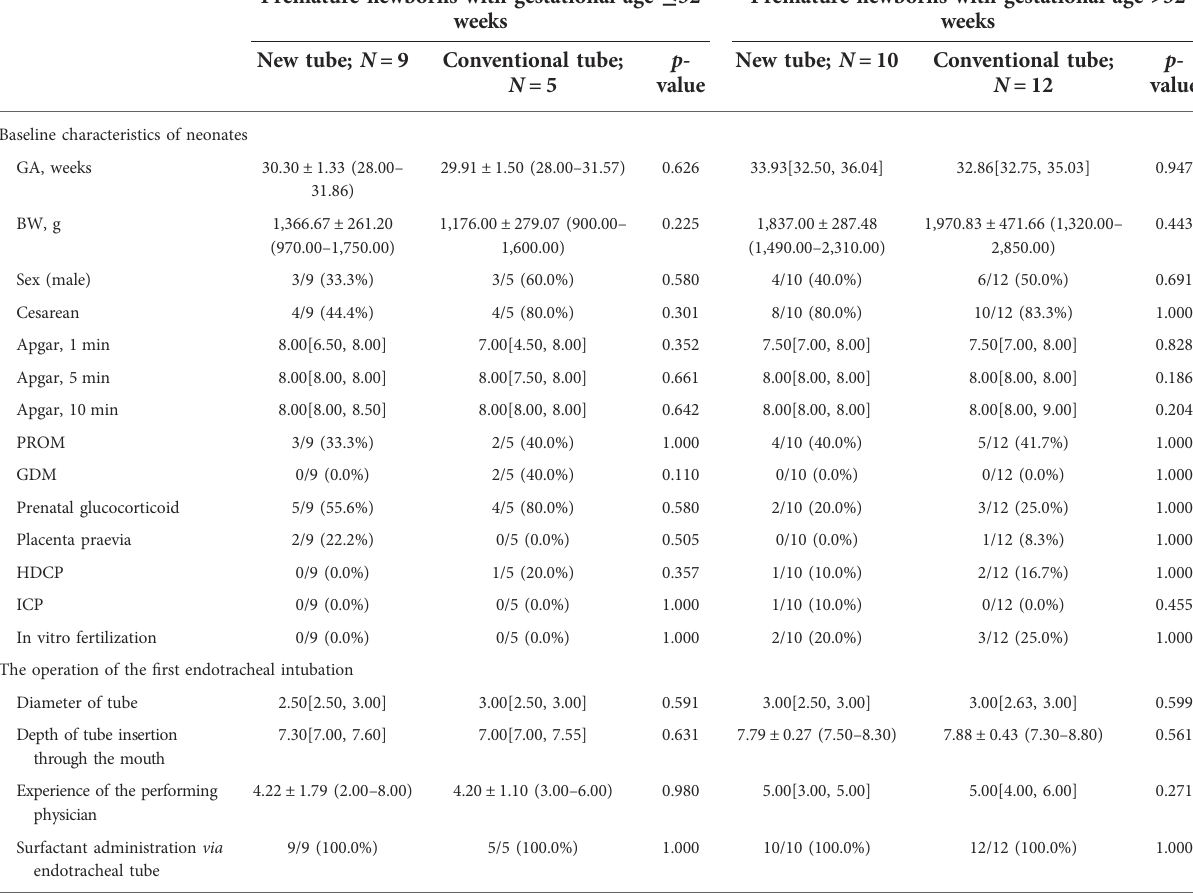
TABLE 6 Basic information on premature newborns with gestational age ≤ 32 weeks and >32 weeks, receiving the inSurE